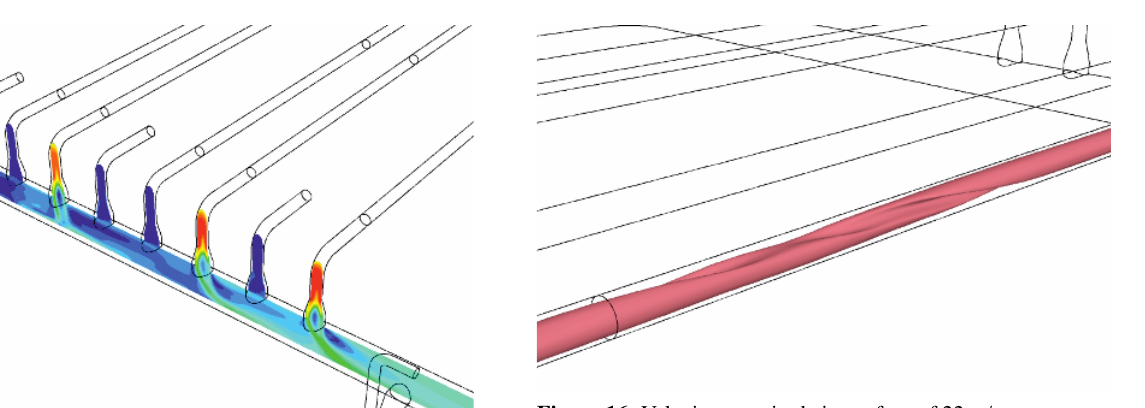
Figure 16: Velocity magnitude isosurface of 22m /